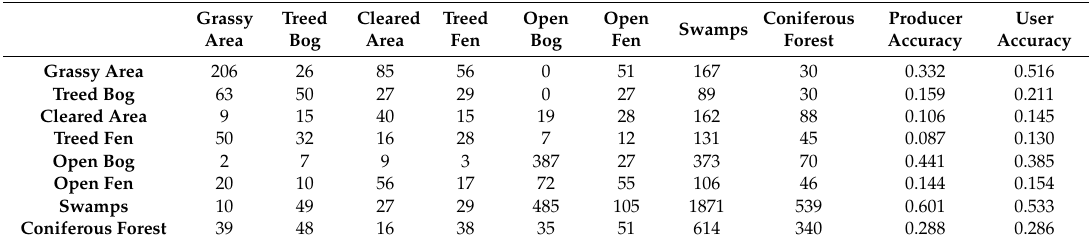
Table 9. Confusion matrix of the worst performing classification test (Naïve Bayes test #225). Grassy